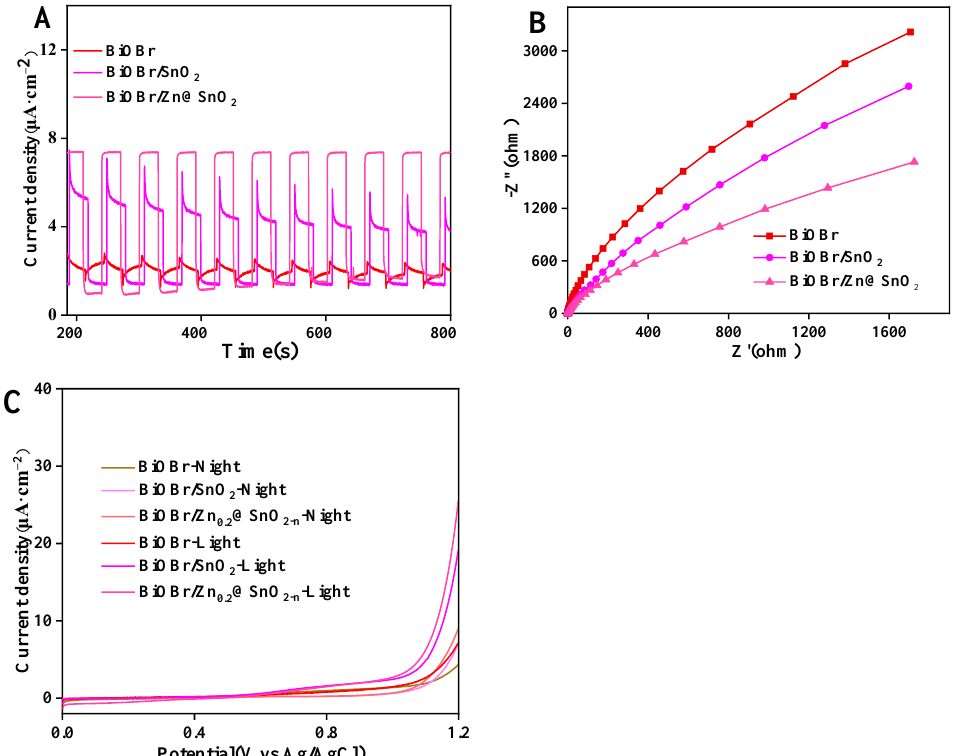
Figure 6. Periodic photocurrent response of BiOBr, BiOBr/SnO 2 and BiOBr/Zn@SnO 2 under visible light irradiation (λ > 420 nm) with 0.1 M Na 2 SO 4 as the electrolyte and 0.5 V vs. Ag/AgCl electrode as the electrode ( A ). Nyquist plots of the electrochemical impedance spectra of the three catalysts ( B ). LSV scans of the three catalysts under bright and dark–light conditions ( C